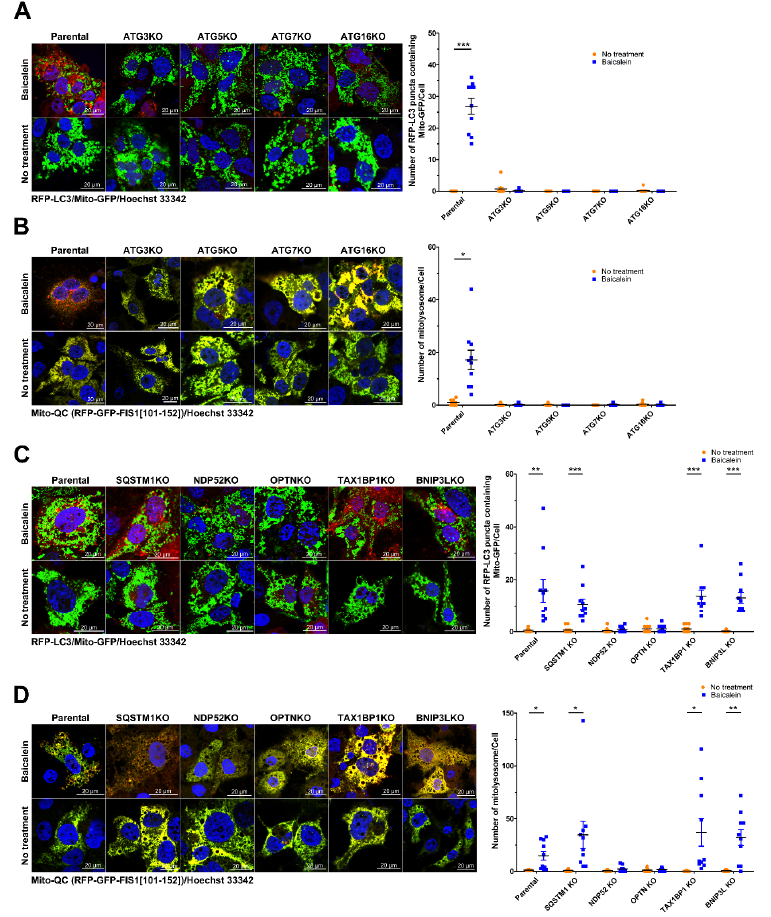
Figure 13. Effects of knocking out the gene expression of ATGs and cargo receptors on baicalein-induced mitophagic degradation: ( A , B ) Huh7 parental and individual ATG-KO cells coexpressing RFP-LC3 and Mito-GFP in ( A ) and expressing Mito-QC in ( B ) were treated with or without 0.5 mM baicalein. Four hours later, the cells were fixed, stained with Hoechst 33342, and analyzed by con- focal microscopy. The number of RFP-LC3 puncta with Mito-GFP ( A ) and the number of mitolyso- somes ( B ) were quantified. The data represent the means ± SEM ( n = 10, * p < 0.05, ** p < 0.01, *** p < 0.001). ( C , D ) Huh7 parental and individual cargo receptor-KO cells stably expressing RFP-LC3 and Mito-GFP in ( C ) and expressing Mito-QC in ( D ) were cultured in the presence or absence of 0.5 mM baicalein for four hours. Then, the cells were fixed, stained with Hoechst 33342, and analyzed by confocal microscopy. The number of RFP-LC3 puncta with Mito-GFP ( C ) and the number of mitoly- sosomes ( D ) were quantified. The data represent the means ± SEM ( n = 10, * p < 0.05, ** p < 0.01, *** p < 0.001).